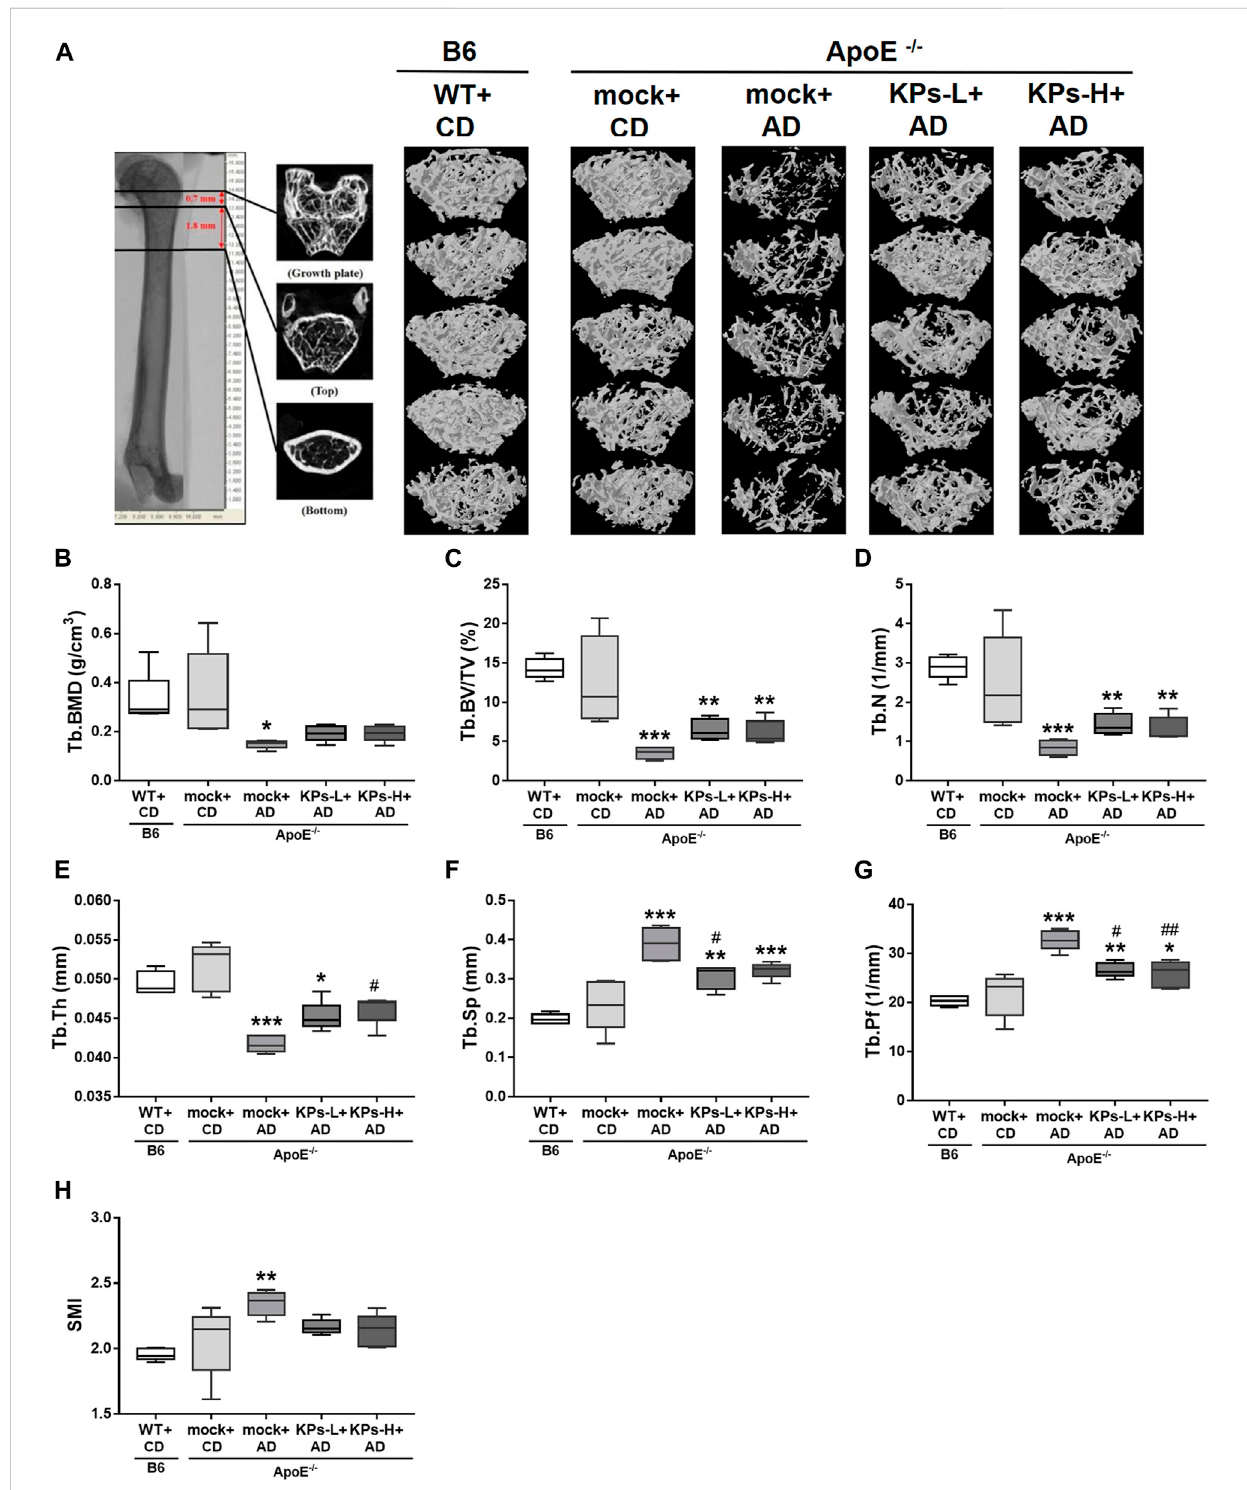
FIGURE 4 KPs prevent trabecular (Tb) bone loss in AD-fed ApoE − / − mice. The effects of KPs on femoral trabecular bones were evaluated using micro-CT. The reconstituted images of Tb structures are presented in a cross-section view (A) . The structural parameters are shown in (B) Tb. BMD, (C) Tb.BV/TV, (D) Tb.N, (E) Tb.Th, (F) Tb. Sp, (G) Tb. Pf, and (H) SMI. Statistical signs ( n = 5): * p < 0.05, ** p < 0.01, *** p < 0.001 vs. WT + CD/B6, and # p < 0.05, ## p < 0.01 vs. mock + AD/ ApoE − / −